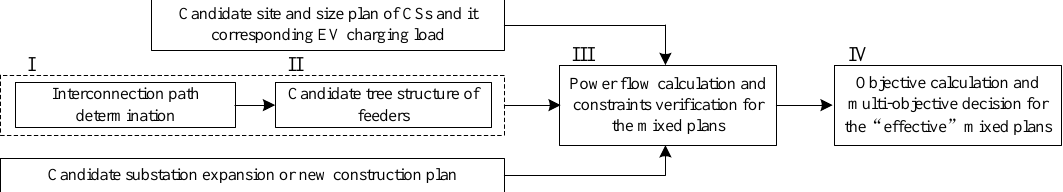
Figure 4. Multi-stage search strategy.